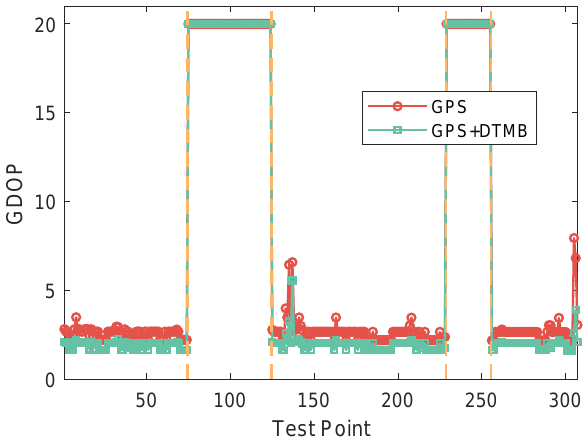
Figure 19. GDOP of GPS and GPS + DTMB at each test point at Site